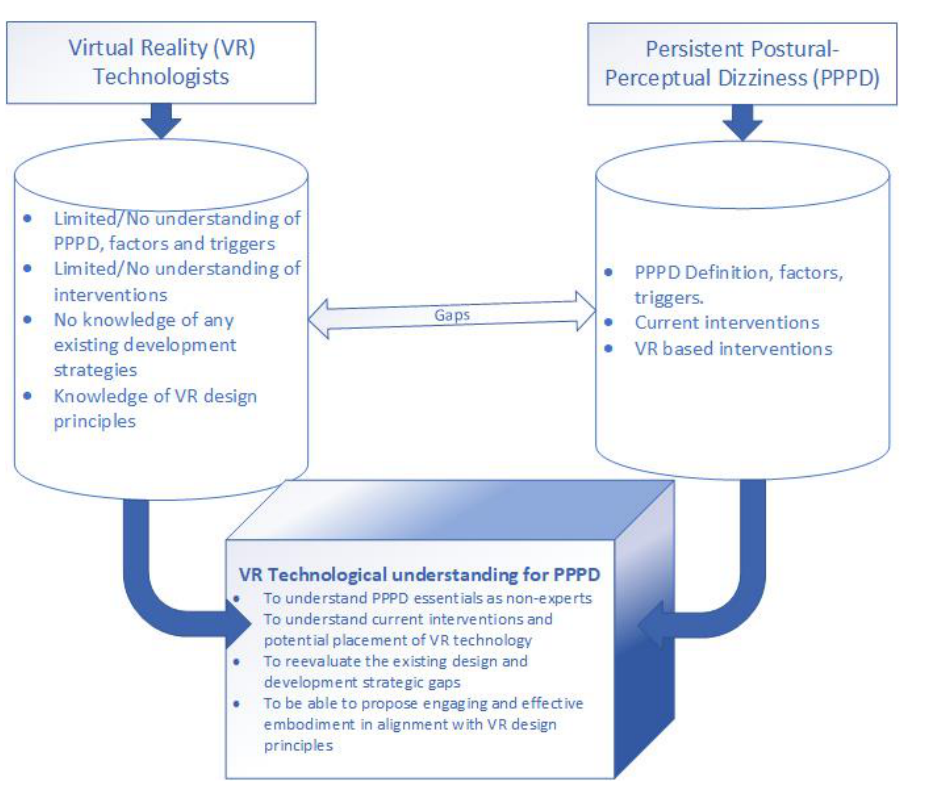
Figure 1. Bridging knowledge gaps of PPPD for VR